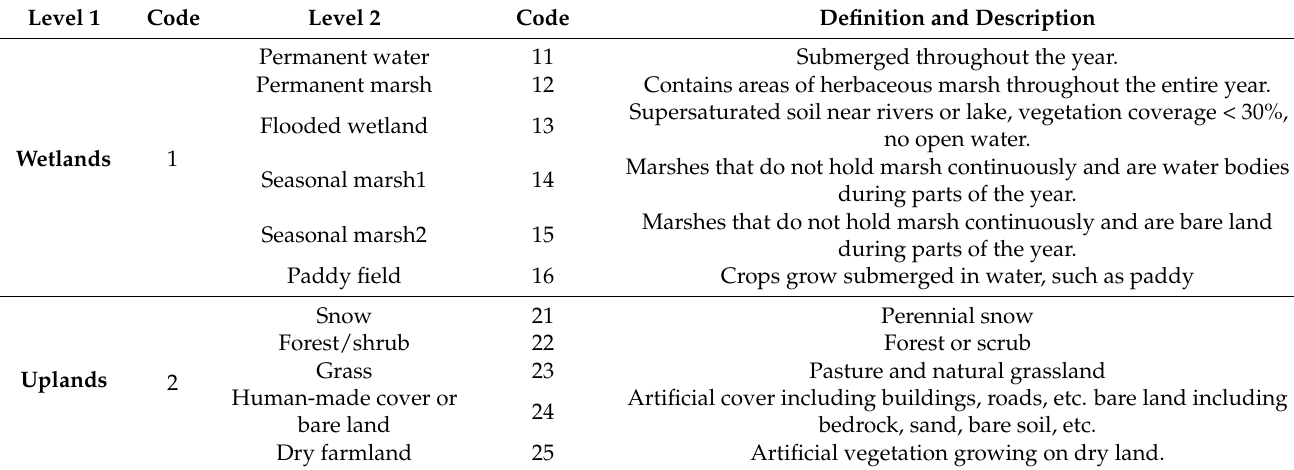
Table 1. Annual wetland classification